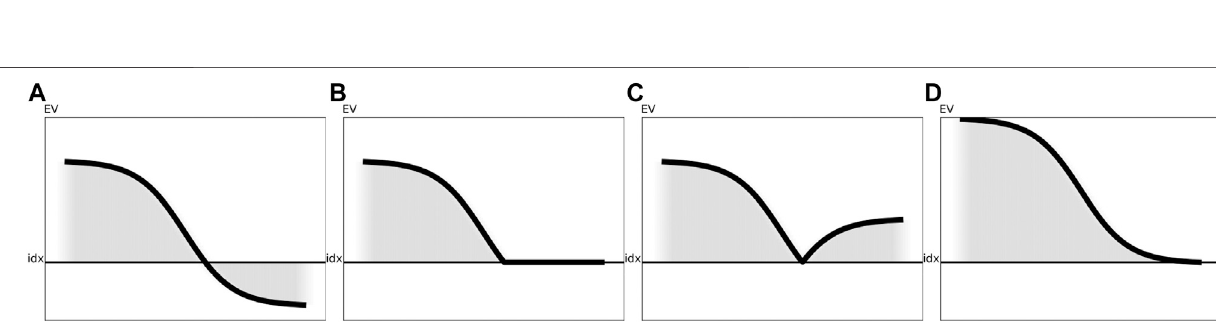
FIGURE3 | Visualizationofthe various preprocessing techniques fora genericeigenspectrum as obtained from ageneric similarity matrix. The black lineillustrates the impact of the respective correction method on the eigenspectrum without reordering of the eigenvalues. (A) Visualization of a sample eigenspectrum with pos./neg. eigenvalues. (B)Preprocessing ofthe eigenspectrum from Figure 3A using clip.(C)Preprocessing ofthe eigenspectrum from Figure 3A using fl ip. (D) Preprocessing of the eigenspectrum from Figure 3A using shift.